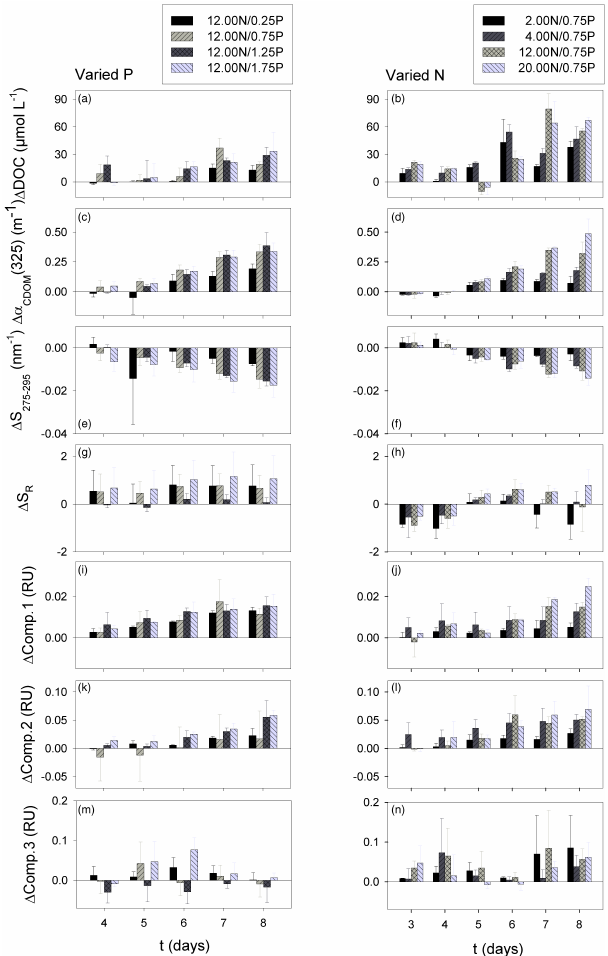
Figure 2. Accumulation over time: of DOC ( (cid:49) DOC) (a) during the Varied P and (b) Varied N; of CDOM ( (cid:49)a CDOM (325)) (c) dur- ing the Varied P and (d) Varied N; of Spectral Slope ( (cid:49)S 275 − 295 ) (e) during the Varied P and (f) Varied N; of spectral slope ratio ( (cid:49)S R ) (g) during the Varied P and (h) Varied N; of first FDOM component fluorescence intensity ( (cid:49) Comp.1 ) (i) during the Varied P and (j) Varied N; of second FDOM component fluorescence inten- sity ( (cid:49) Comp.2) (k) during the Varied P and (l) Varied N; of third FDOM component fluorescence intensity ( (cid:49) Comp.3) (m) during the Varied P and (n) Varied